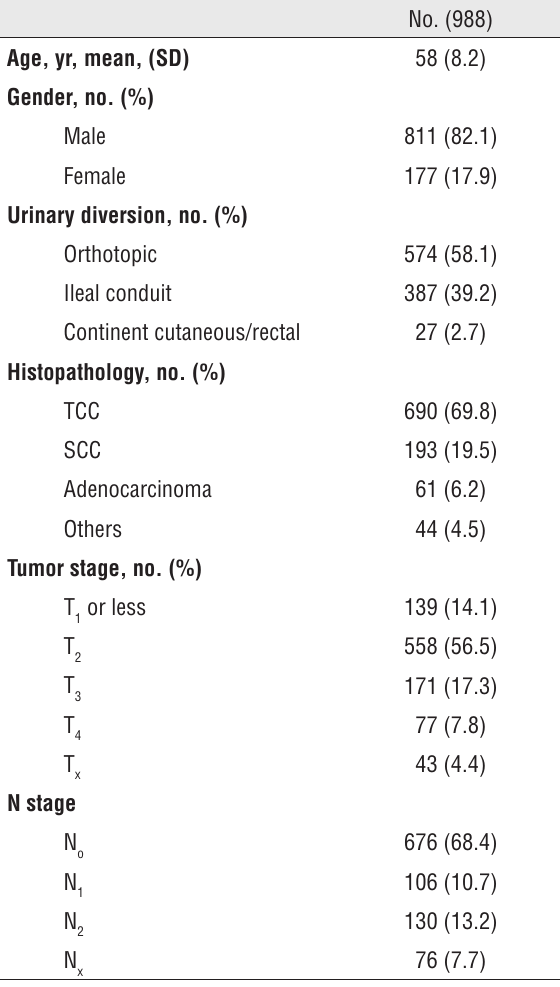
Table 1 - Demographics for patients undergoing radical cystectomy and urinary